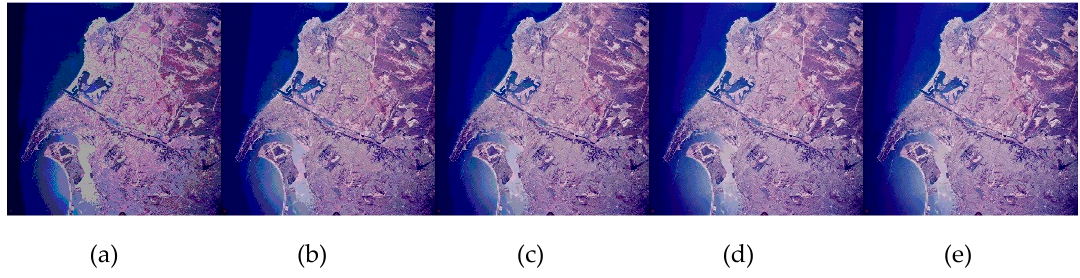
Figure 8. The segmented results of Satellite image1. ( a ) WOA; ( b ) FPA; ( c ) PSO; ( d ) BA; and ( e ) HSOA.